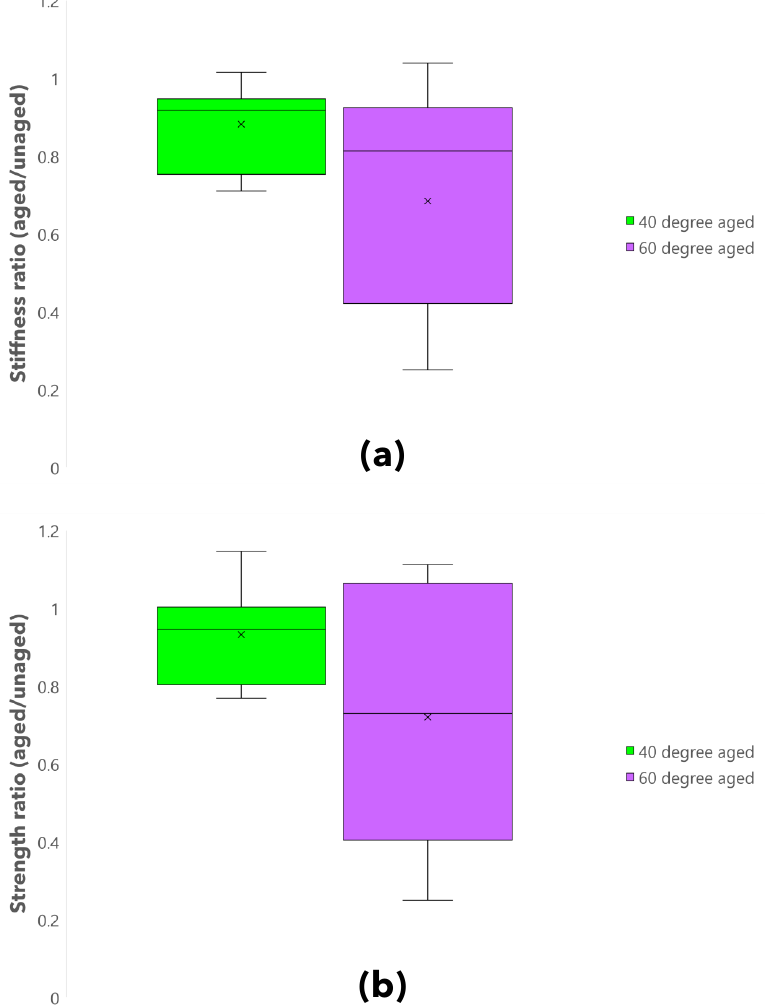
Figure 5. Box and whisker plot of ( a ) the stiffness ratio and ( b ) the strength ratio of composite groups at 40 ◦ C ageing and 60 ◦ C ageing to their unaged